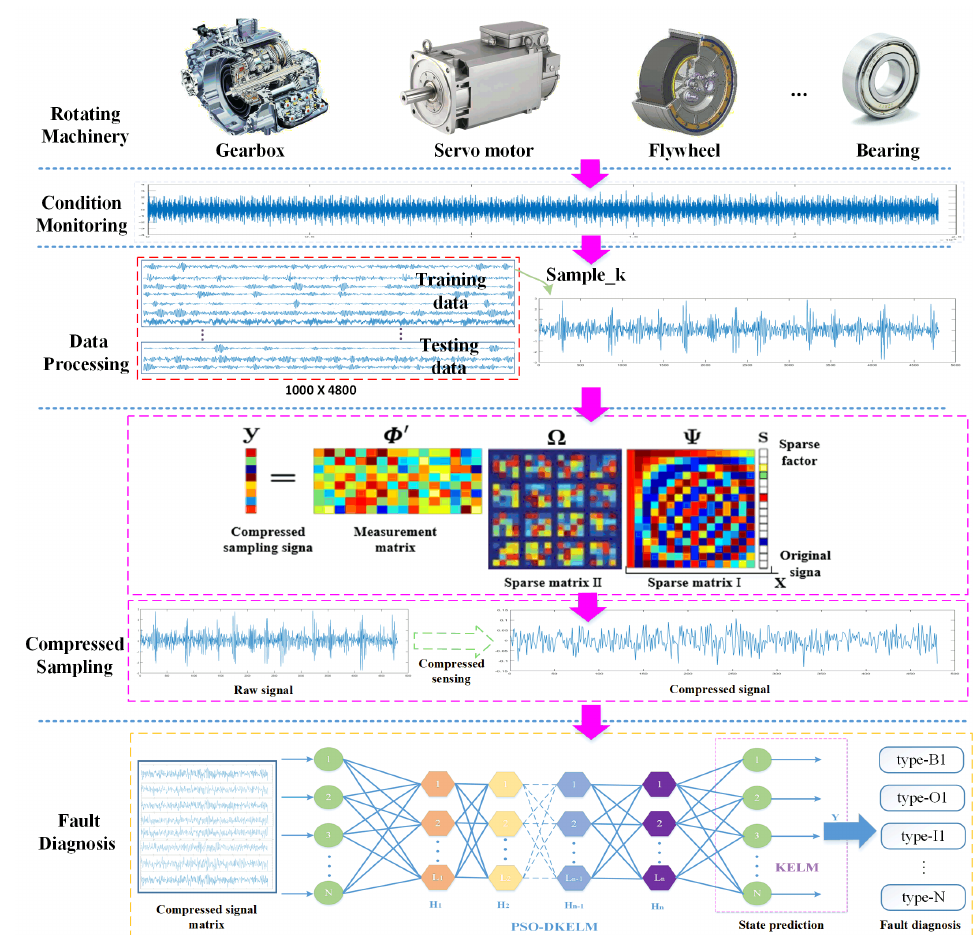
Figure 1. The procedure of the proposed CS-DKELM